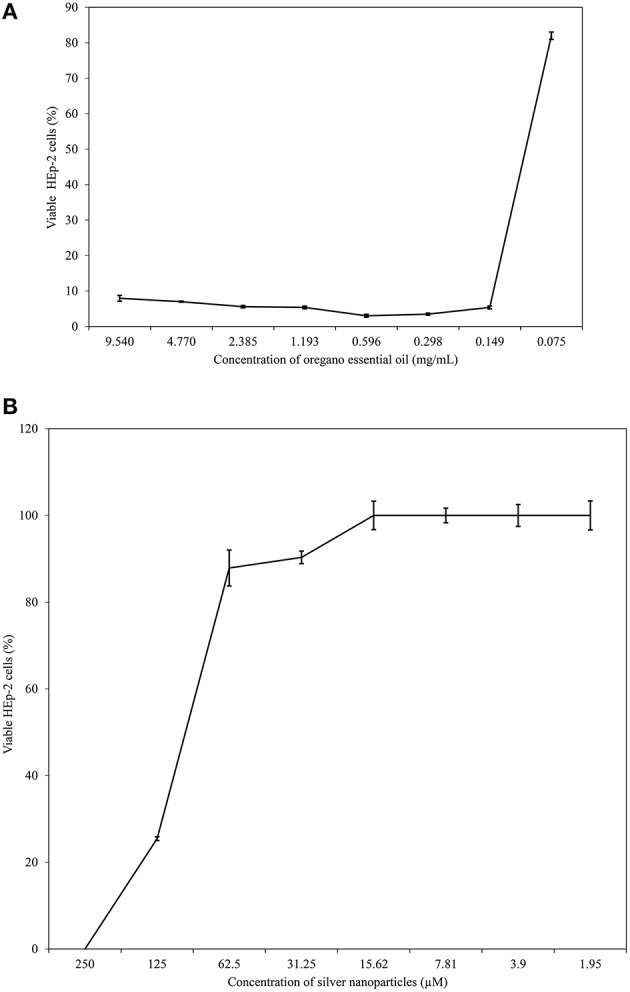
HEp-2 cell viability at different concentrations of OEO and bio-AgNP individually. (A) HEp-2 cell exposed to OEO alone ranging from 0.075 to 9.540 mg/mL. (B) HEp-2 cell exposed to bio-AgNP alone ranging from 1.95 to 250 μM. Percentage values of cell viability are the mean ± standard deviation.